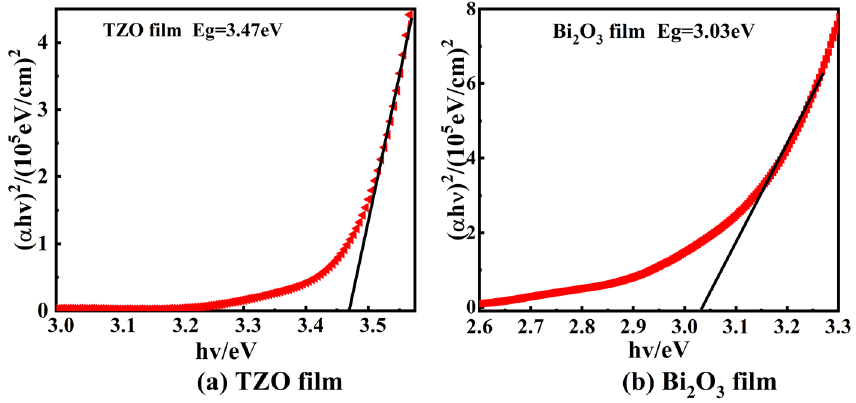
Figure 6. Plots of ( α hυ ) 2 versus photon energy ( hυ ) of ( a ) TZO and ( b ) Bi 2 O 3